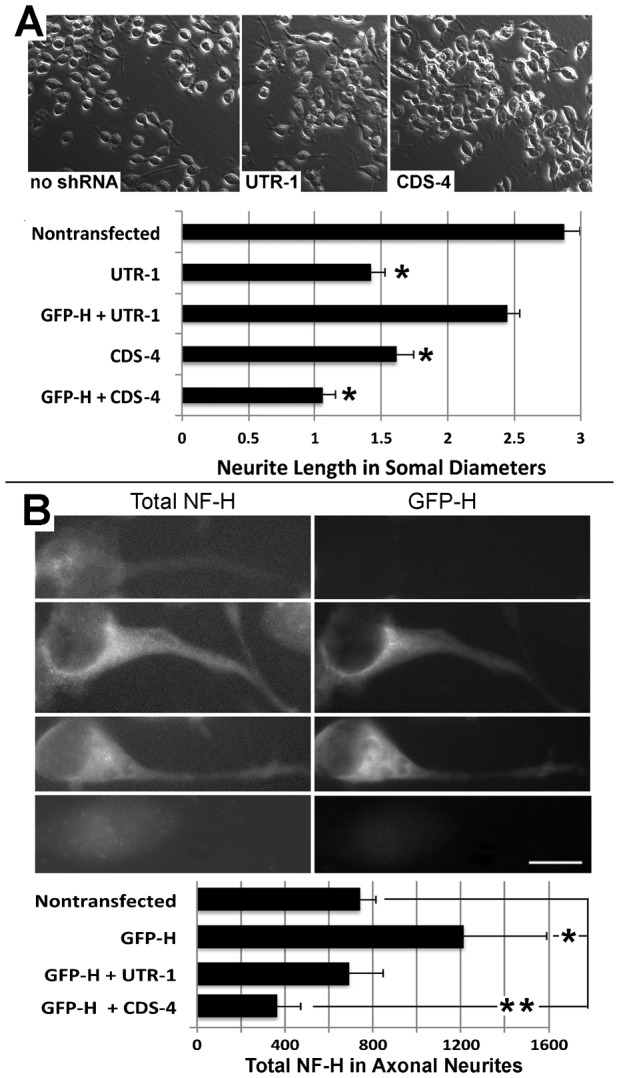
Exogenous NF-H prevents the shRNA-mediated reduction in axonal length.(A) Representative phase-contrast micrographs of cells were transfected with GFP-H without and with co-transfection with a shRNA corresponding to the untranslated region of mouse NF-H (UTR-1) or a coding sequence shared by both rat and mouse NF-H (CDS-4; Table 1). The accompanying graph presents quantification of neurite length as a function of respective somal diameters for nontransfected cells and cells transfected with GFP-H without and with co-transfection with UTR-1 or CDS-4 as indicated. Transfection with UTR-1 or CDS each reduced neurite length; cotransfection with GFP-H curtailed the reduction in neurite length mediated by UTR-1 but not by CDS-4 (asterisk indicate p<0.001, ANOVA with Fischer's post-hoc analyses). (B) Representative immunofluorescent images of total NF-H cells transfected as in panel A. The accompanying graph presents quantification of total NF-H within axonal neurites. A single asterisk indicates an increase (p<0.04) and the double asterisk indicates a decrease (p<0.04) in total axonal NF-H versus levels in axons of nontransfected cells; Student's t test). Bar: 25 µm.